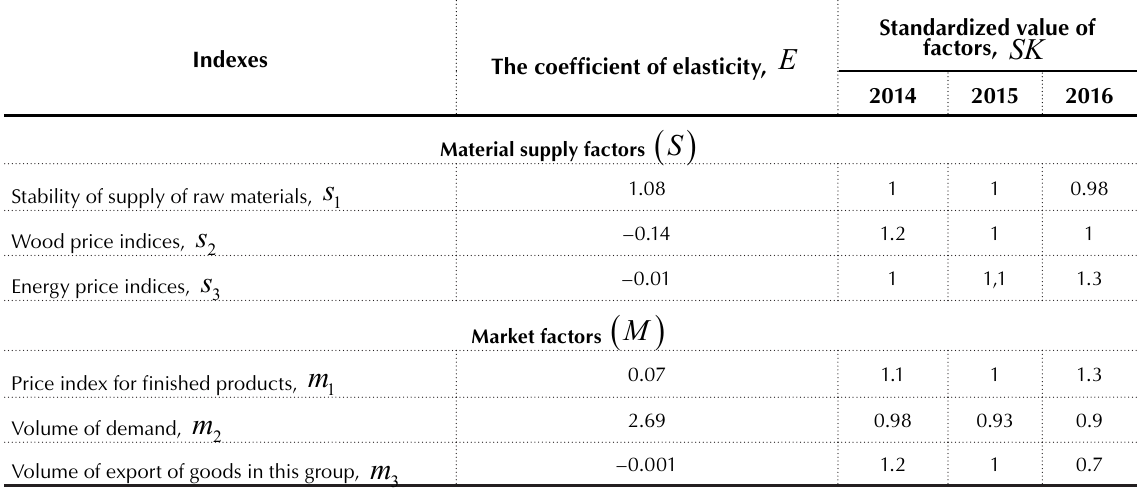
Table 3. Standardized indicators of external strategic control Indexes The coefficient of elasticity, E